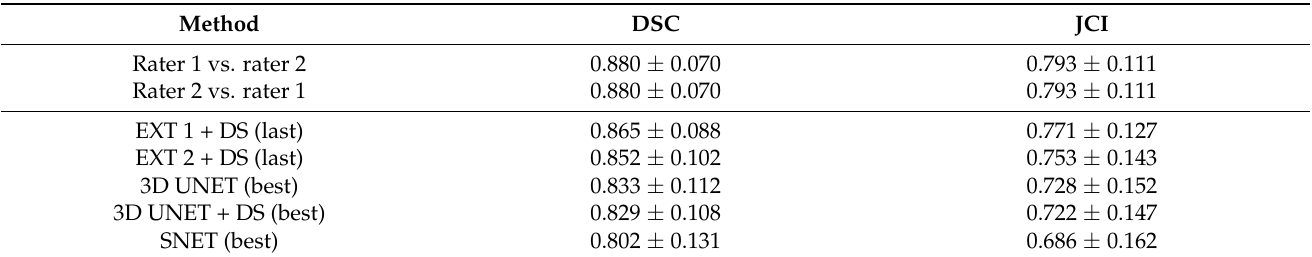
Table 7. Effectiveness of the proposed ovary detection methods compared to the state-of-the-art and inter-rater variability. Presented are the mean and Standard Deviation of the Dice Similarity Coefficient (DSC) and Jaccard Index (JCI) on the USOVA3D database.